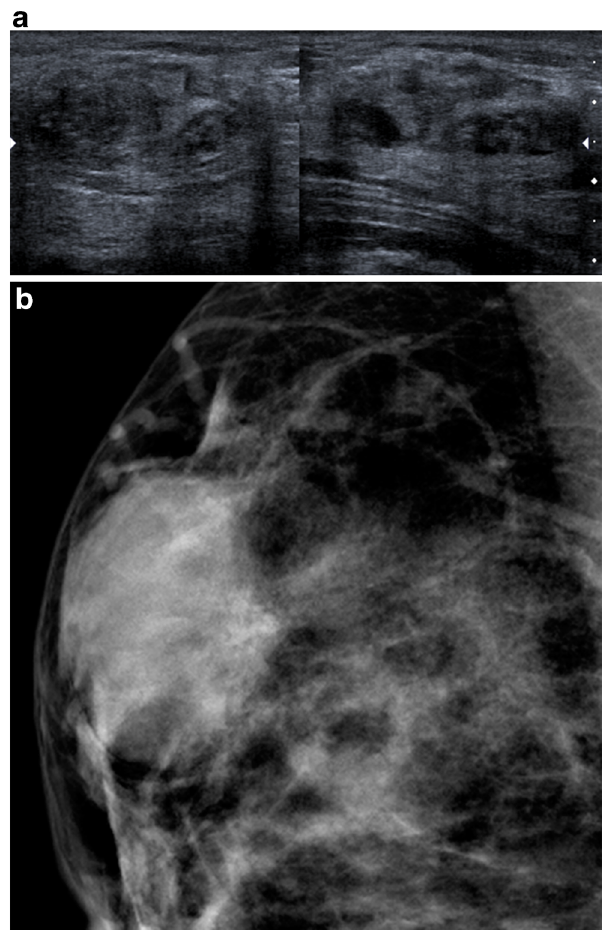
Fig. 7 Hamartoma. a Ultrasound showing an oval-shaped mass with mixed echogenicity, globally isoechoic, with an edge effect artefact. b Mammography showing a well-circumscribed, dense, oval-shaped mass, with a slightly heterogeneous appearance related to its mixed content (fat and stroma)